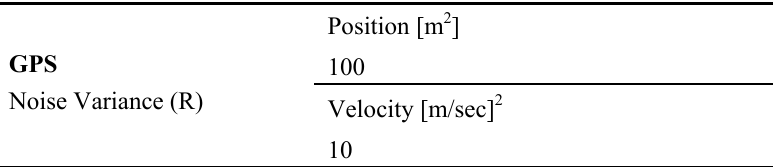
Table 2. Simulated measurement